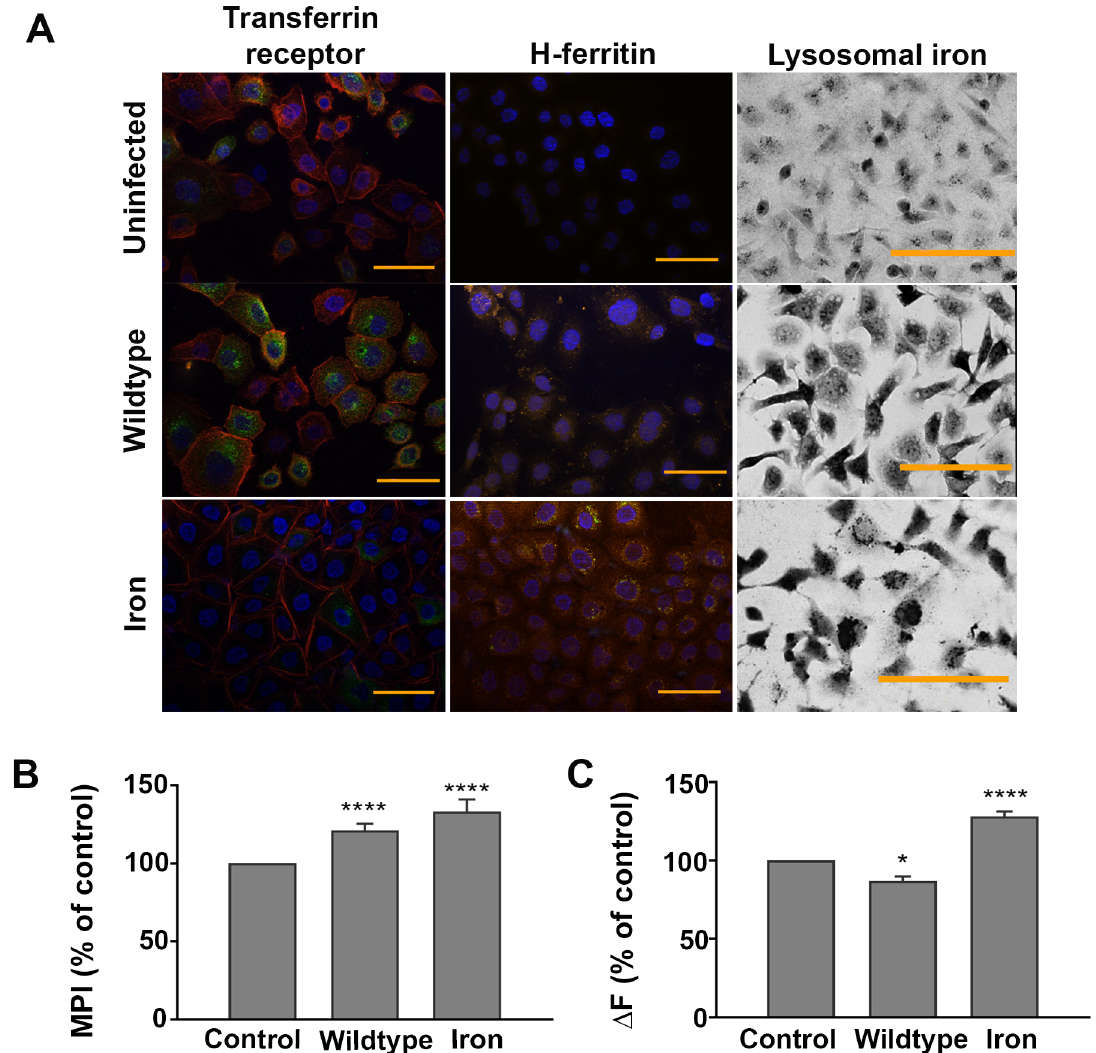
Fig 2. Distribution of transferrinreceptorand H-ferritin in H . pylori -infected AGScells. AGS cellsinfectedwith H . pylori strain60190(MOI, 10:1)or supplementedwithironsulphate(100 μ m)for 15 h werefixedandstainedwithAlexaFluor488-labelled transferrinreceptor(green), TexasRed-conjugatedphalloidin-stainedactin(red)andHoechst33342-stained nuclei(blue)innon- permeabilizedcells; Streptavidin-Phycoerythrin-stainedH-ferritin (orange)andHoechst33342-stainednuclei(blue)in TritonX-100 permeabilizedcells, andlysosomalironusingsulphide-silver(left, middleandrightcolumns,respectively). The images,whichare representative of threeindependentexperiments, denotecellswithno bacteria(Uninfected), infectedwith H . pylori strain60190 (Wildtype) orsupplemented with100 μ mironsulphate(Iron)for 15 h. All imagesweretakenwiththe sameexposuretime for each channel.Bar= 50 μ m. (B) The meanpixelintensity(MPI) of sulphide-silverstainedAGS cellsfollowinginfectionwith H . pylori or supplemented withironsulphate calculated usingImageJsoftware, withlevelsof lysosomal iron(evidencedbyMPI) expressedas a percentageof that observedin uninfected (Ctrl) cells. (C) H . pylori- infectedandiron-supplementedAGS cellstreatedwithcalcein, withandwithouttheadditionof SIH to measurethecytosoliclabileironpool.Results, whichshowan increasein fluorescence( Δ F) in infectedandiron-supplementedcells,arepresentedas a percentage of uninfectedcells. (B) Resultsare ± SEM of five images takenfrom threeindependent experiments and (C) , ± SEM of 3 independentrepeats. * , **** ,resultsarestatisticallydifferentfrom thoseof untreatedcontrols(P < 0.05and < 0.0001,respectively), asdetermined byone-wayANOVA withTukey’stest for multiple